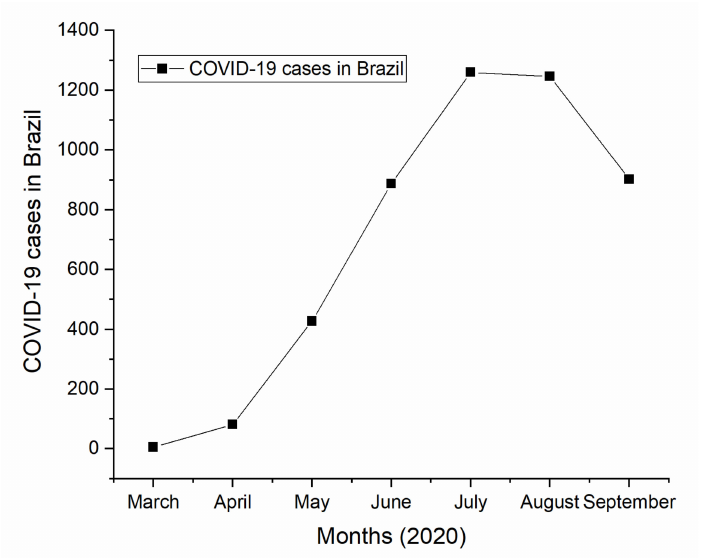
Figure 1. Evolution of COVID-19 cases in Brazil from March to September